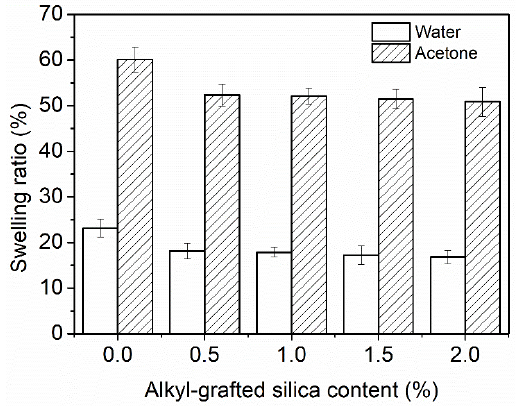
Figure 7. Water and acetone swelling ratio of coatings.